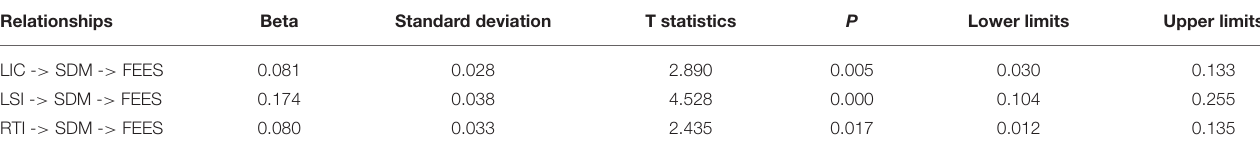
TABLE 5 | Indirect path. Relationships Beta Standard